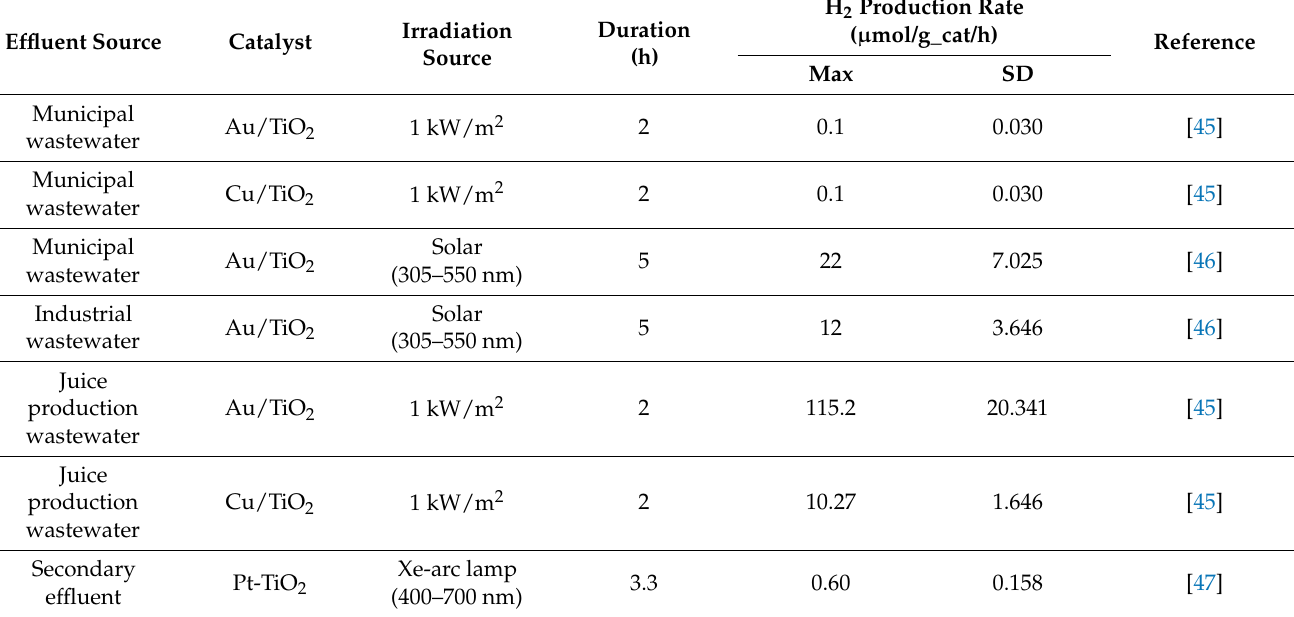
Table 4. Photocatalytic hydrogen production from selected wastewater